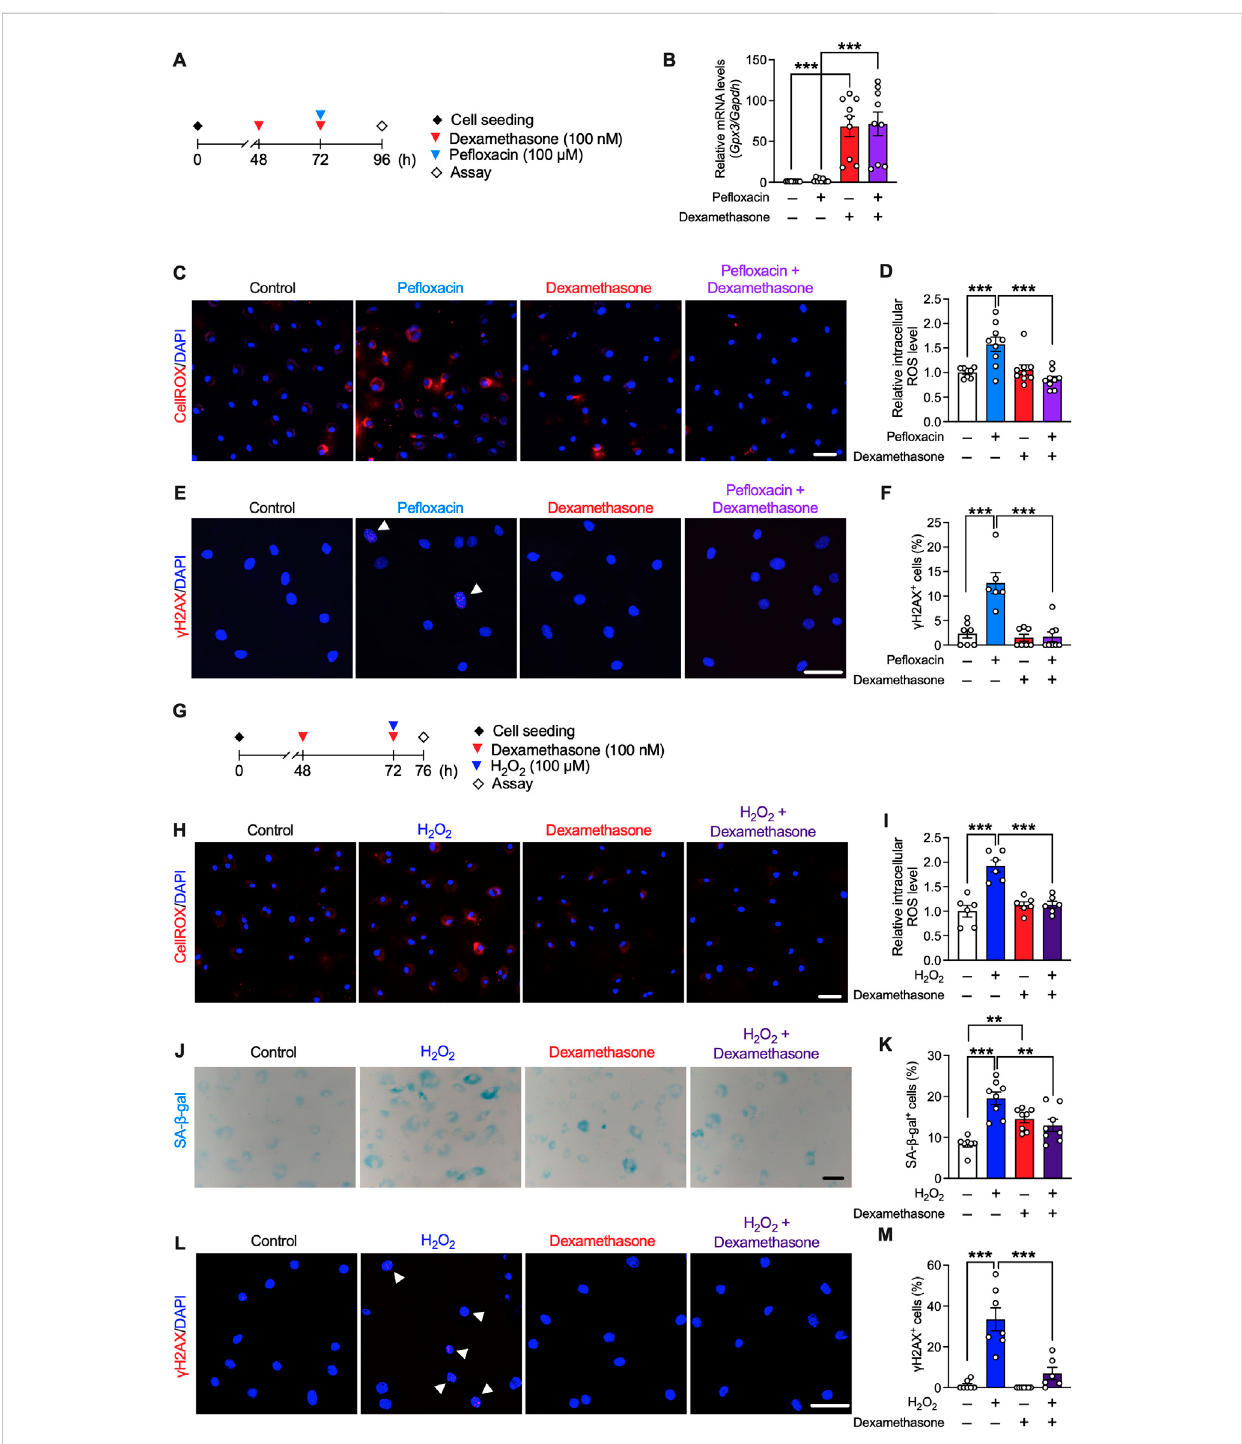
FIGURE 6 Effects of dexamethasone on pe fl oxacin-induced toxicity and stress-induced senescence in rat primary tenocytes. (A) Primary cultured tenocytes obtainedfromratAchillestendonsweretreatedwithpe fl oxacin(100 µM,24 h),dexamethasone(100 nM,24 hpre-treatmentplus24 hco-treatment),or both. (B) The gene expression of Gpx3 after drug treatment was examined using quantitative RT-PCR ( n = 9 per group) and represented as the relative ratioto thecontrolgroup. (C,D) Thelevels ofreactiveoxygen species(ROS) wereevaluated usingtheCellROXassay ( n =8 – 9pergroup). Cellswere imagedusingconfocalmicroscopy,andtheintensityof fl uorescencewasmeasuredineachcell. (E,F) Thenumberofcellswiththreeormore γ H2AX + foci was counted (shown with an arrowhead) and presented as a percentage of the total cell number. (G) Primary cultured tenocytes were treated with H 2 O 2 (100 µM, 4 h) to create a stress-induced senescence model and co-treated with dexamethasone (100 nM, 24 h pre-treatment plus 4 h co-treatment). (H,I) The levels ofROS after drug treatment wereevaluated using theCellROX assay ( n = 6 per group). (J,K) Senescence-associated β -galactosidase (SA- β -gal)stainingwasperformedafterdrugtreatment( n =7 – 8pergroup).ThenumberofSA- β -gal + cellswascountedandpresentedasapercentageofthe total number of cells. (L,M) Immunostaining of γ H2AX was performed ( n = 6 – 7 per group). The number of cells with three or more γ H2AX + foci (shown witharrowhead) ispresented as apercentageofthenumberof totalcells. Dataare shown asmean± SEM.Statisticalsigni fi cance wastested usingatwo- way ANOVA with post hoc multiple comparisons; ** p < 0.01, *** p < 0.001. Scale bar; 50